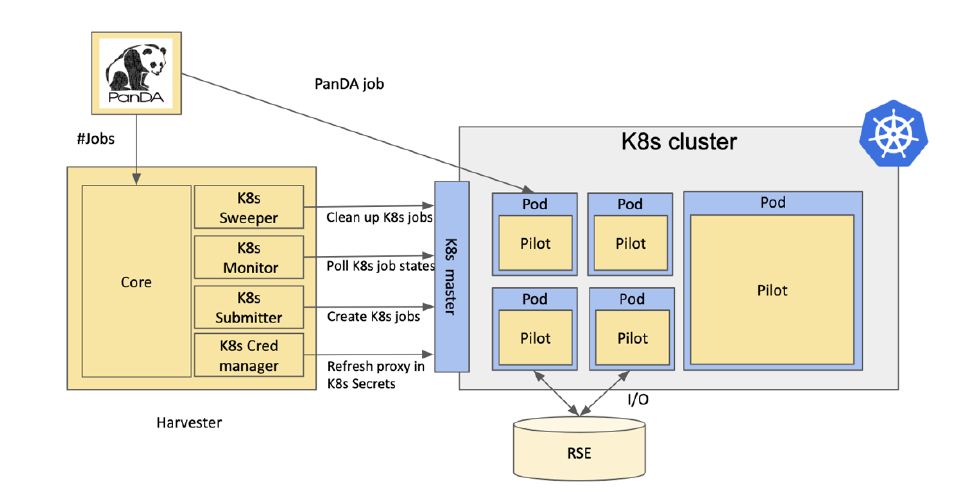
Fig. 2 . Harvester-Kubernetes integration